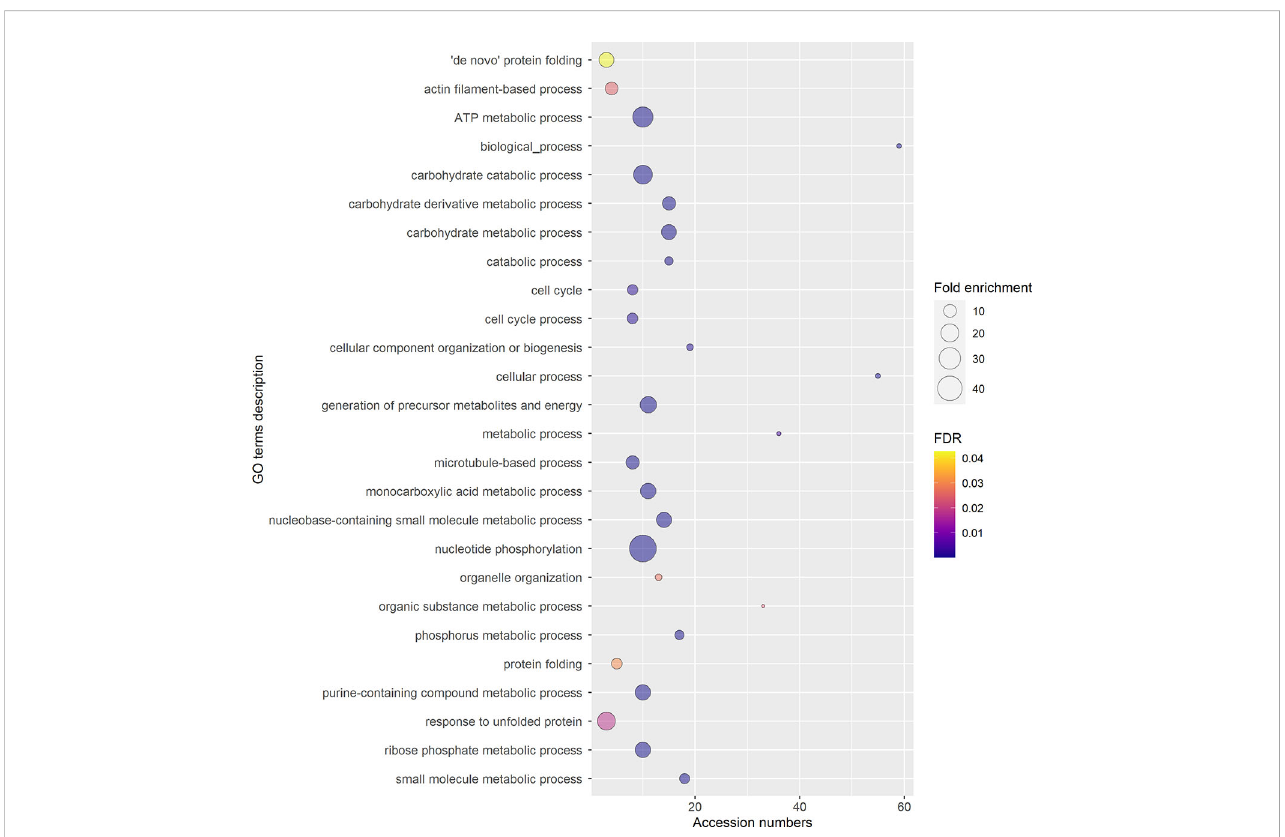
FIGURE 7 Gene Ontology (GO) terms for Biological Process, relative to the 97 selected accession numbers identi fi ed in extracellular nanovesicles from germinated pollen of Actinidia chinensis Planch. GO terms were provided by Panther Classi fi cation System version 17.0 and shortened by REVIGO using SimRel similarity measure. The diameter of the bubbles indicates the overrepresentation of the term when compared to the whole Actinidia chinensis Planch. genome (Fold enrichment), while the color indicates the False Detection Rate (FDR) value. GO terms with FDR>0.05 are not